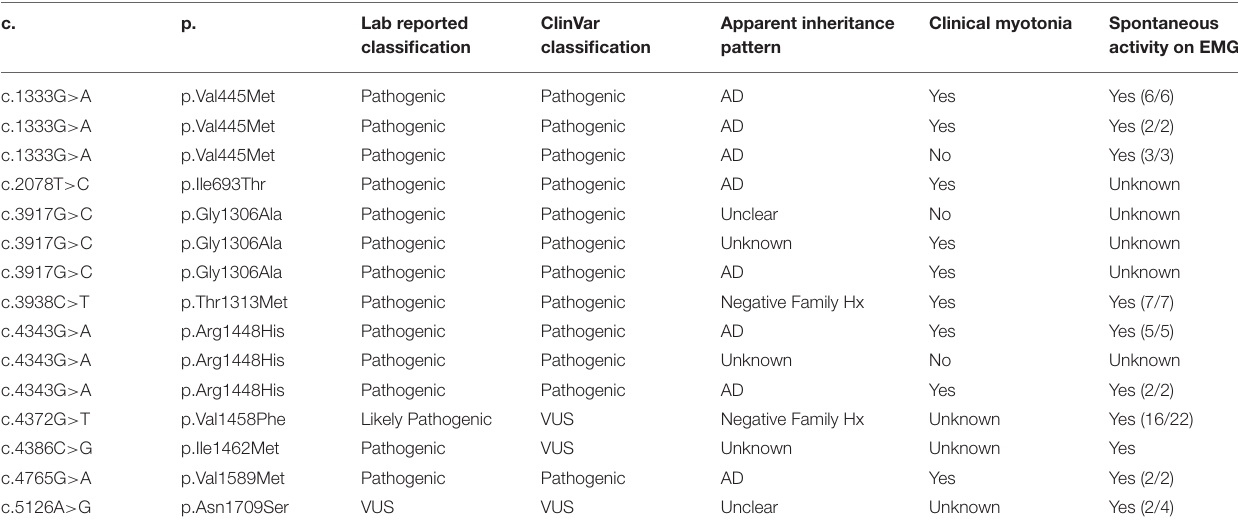
TABLE 4 | List of patients with variants in SCN4A